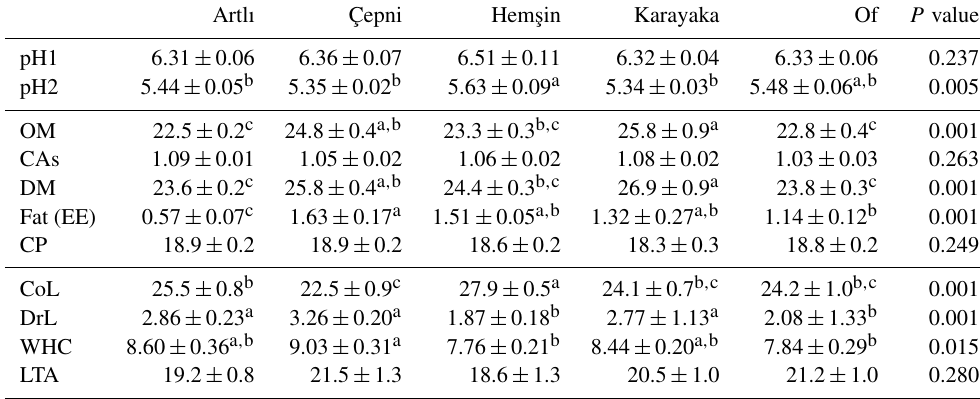
∗ Samples were taken from 10 animals per breed. The abbreviations/variables listed in the table are as follows: pH1 – hot carcass pH values, pH2 – cold carcass pH values, OM – organic matter (%), DM – dry matter (%), CP – crude protein (%), CAs – crude ash (%), CoL –